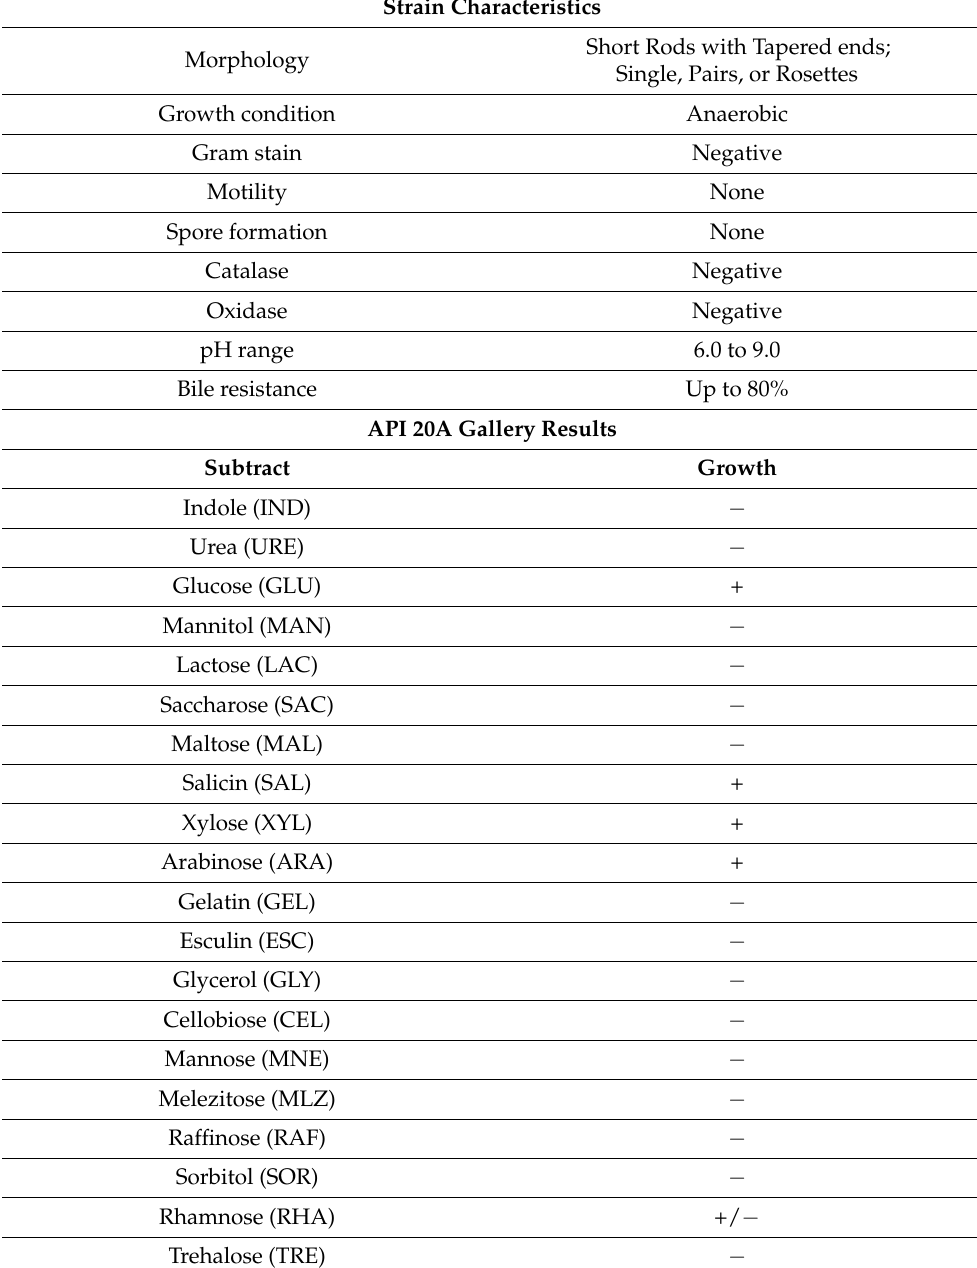
Table 1. Physiological and biochemical properties of C. minuta DSM